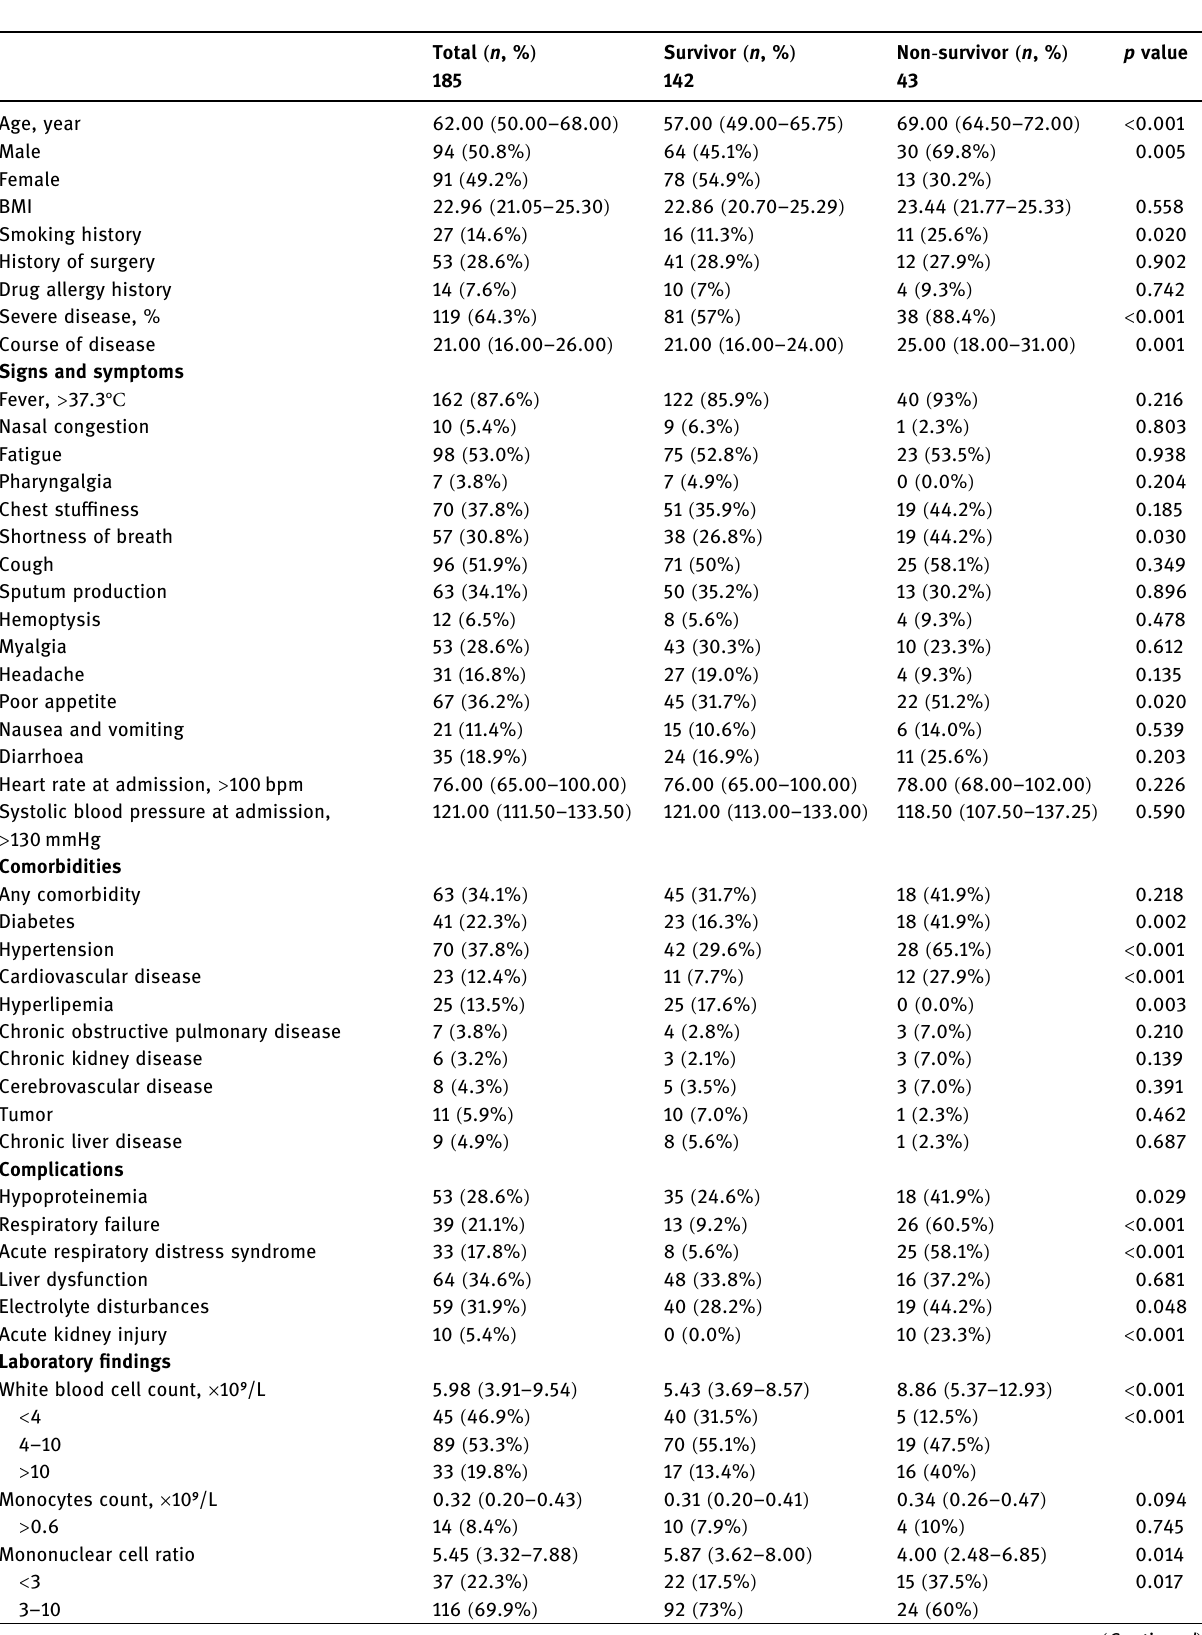
Table 1: Baseline